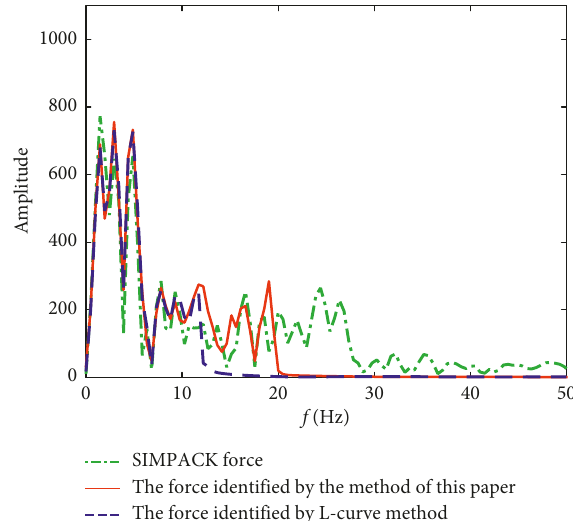
Figure 16: Amplitude-frequency curve of the two methods for F identification when the noise level is 4